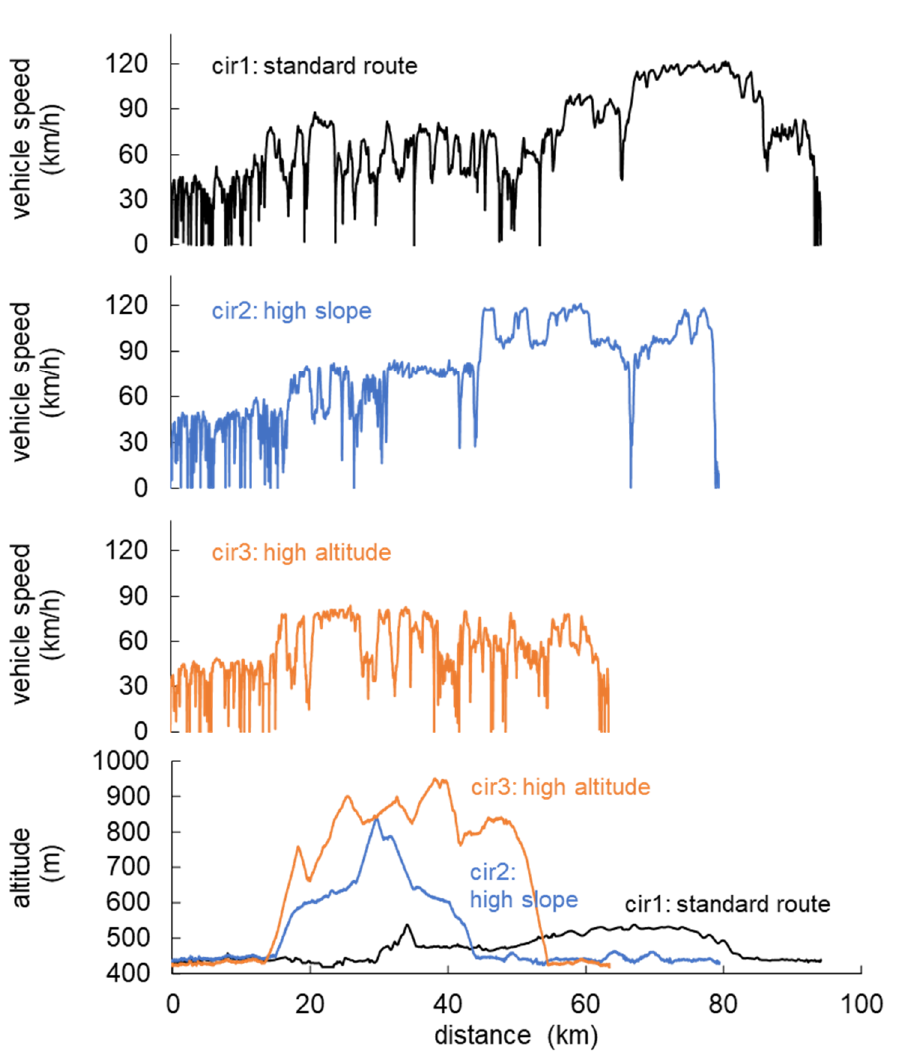
Figure 10. Speed and altitude profiles of the used test circuits: cir1-standard route, cir2-high slope, cir3-high altitude, gasoline (V1).